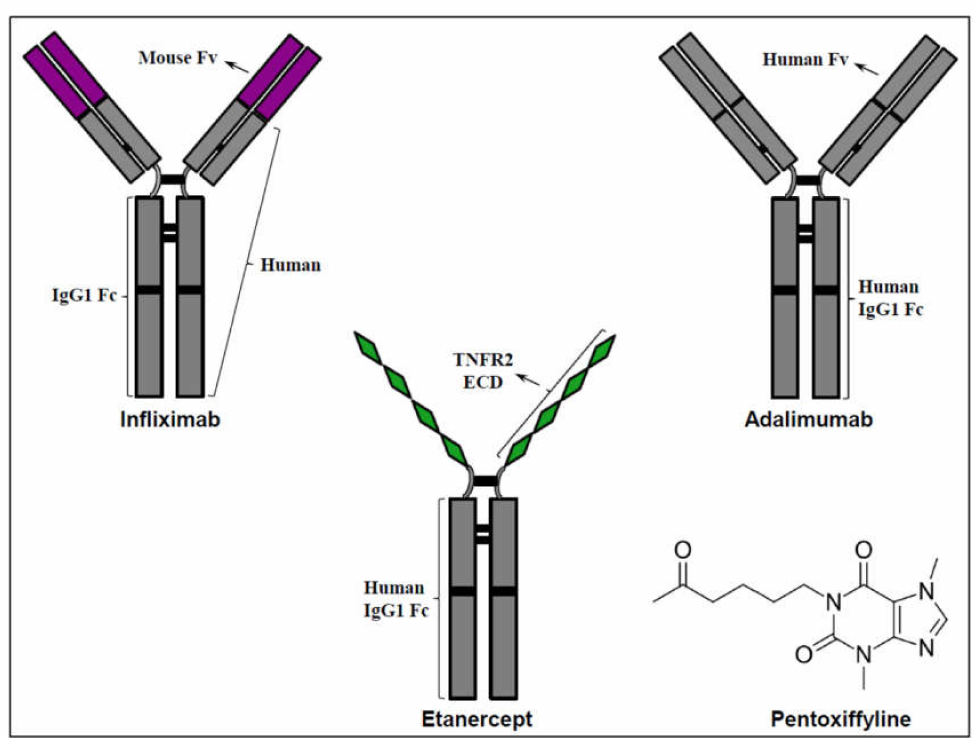
Figure 2. TNF- α Antagonists. Clinically used selective TNF- α antagonists include recombinant TNF- α -specific monoclonal antibodies such as infliximab and adalimumab, and recombinant fusion proteins of TNFR such as etanercept which is a TNFR2 fusion protein. Pentoxifylline is a methylxanthine drug which exerts several pharmacological effects including potent inhibition of TNF- α activity (i.e., it is not a selective TNF- α antagonist). Abbreviations: ECD—extracellular domain, Fc—fragment crystallizable region, Fv—variable fragment, IgG—immunoglobulin G, TNFR2 – TNF- α receptor